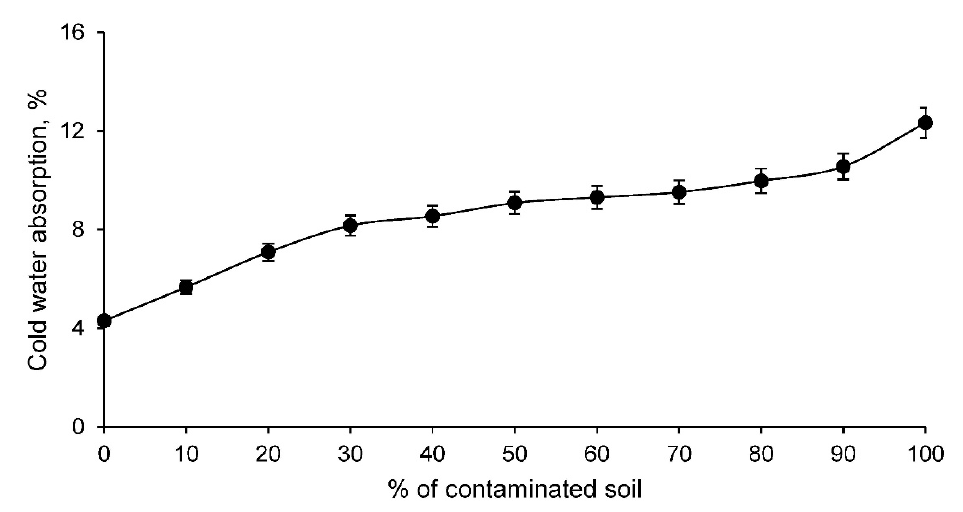
Figure 5. Cold water absorption of conforming ceramics families with various percentages of clay and contaminated soil.